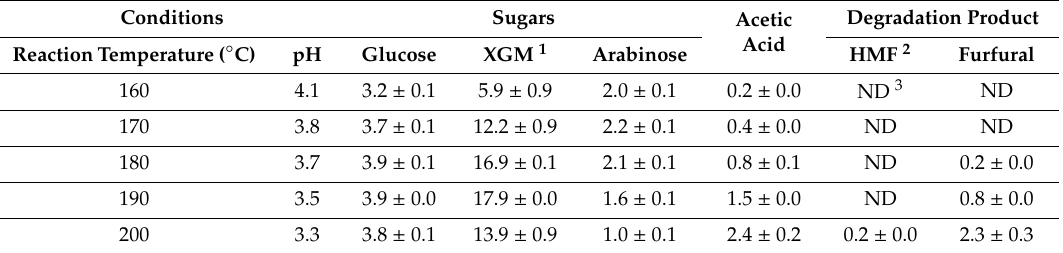
Table 2. Chemical composition of the liquid hydrolysate by reaction temperature